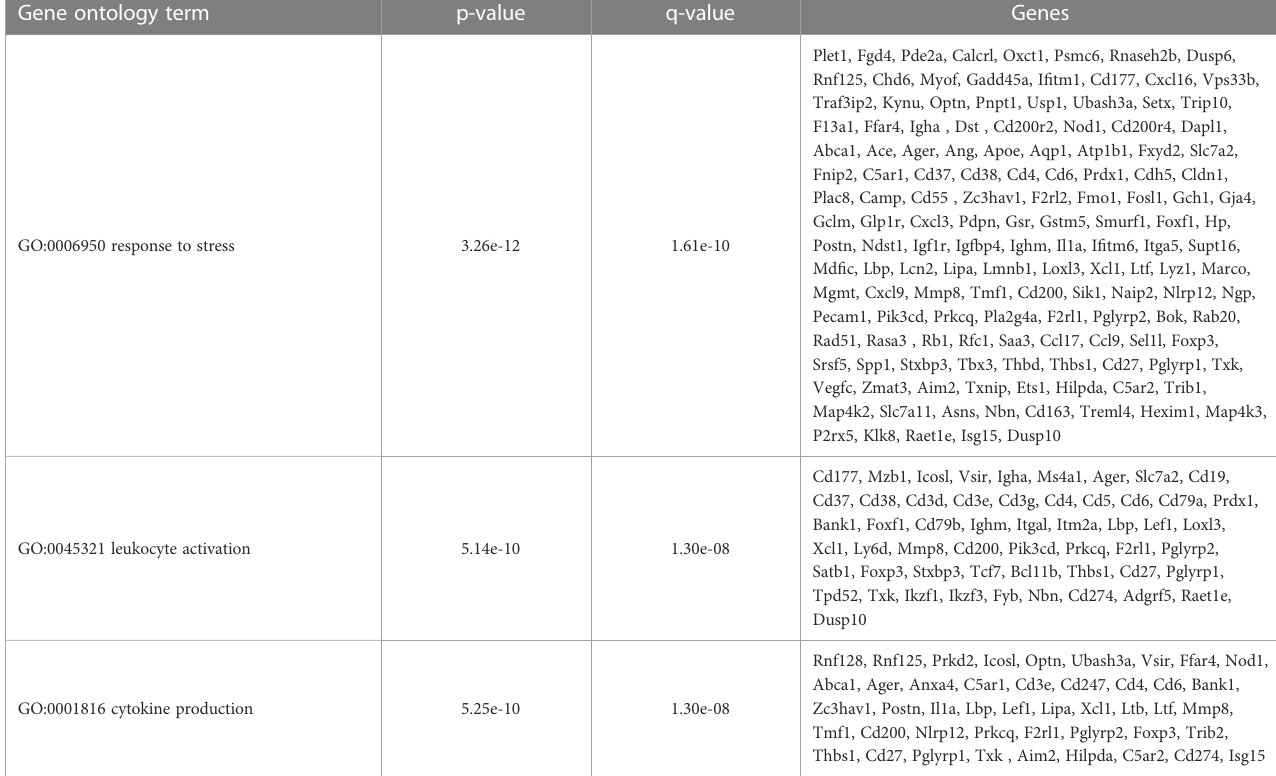
TABLE 5 CD11b-hi DCs selected overrepresented gene ontology terms. Gene ontology